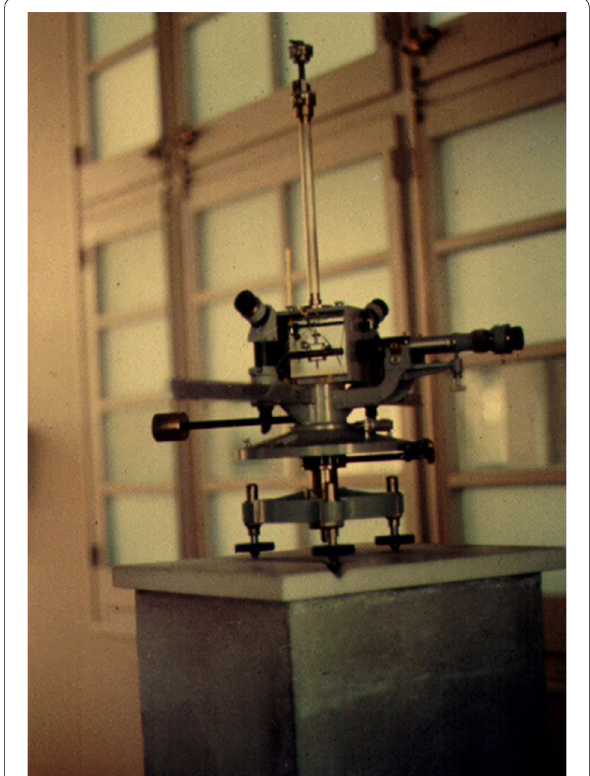
Fig. 2 Declinometer RUSKA at Ebro Observatory